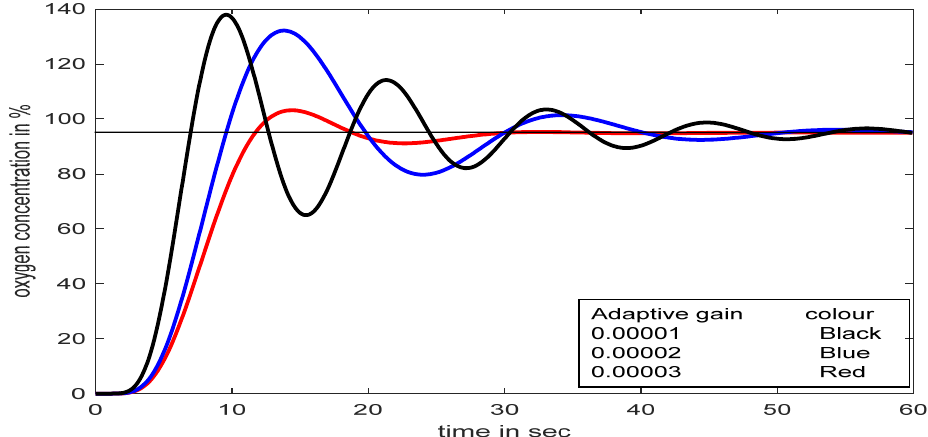
Figure 15. Responses with MRAC for set ‐ point at 95% SpO 2 .